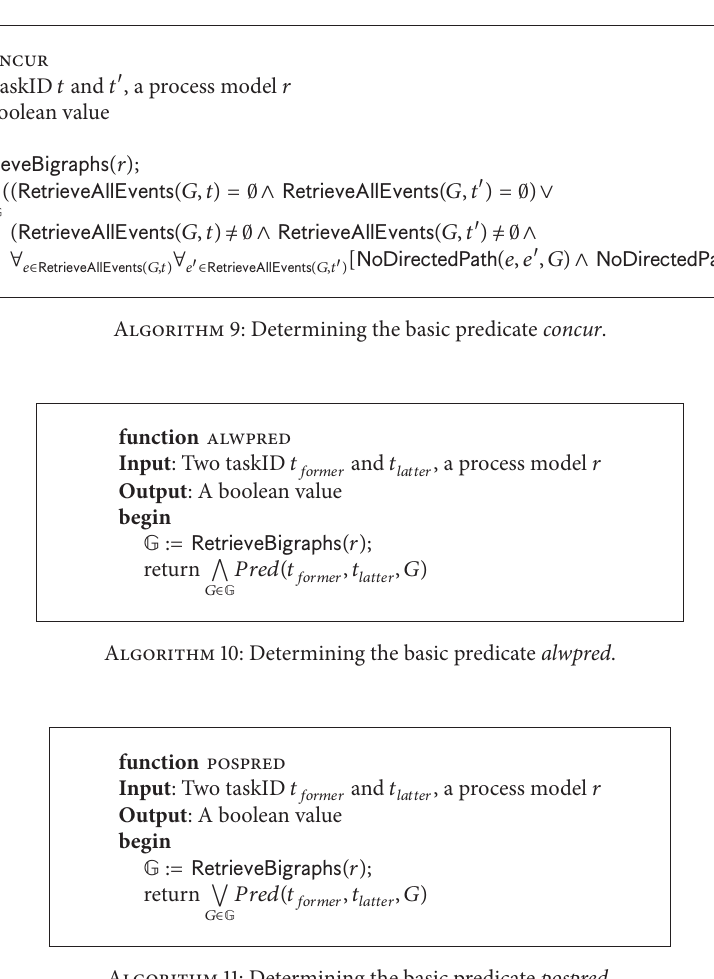
Algorithm 11: Determining the basic predicate pospred .